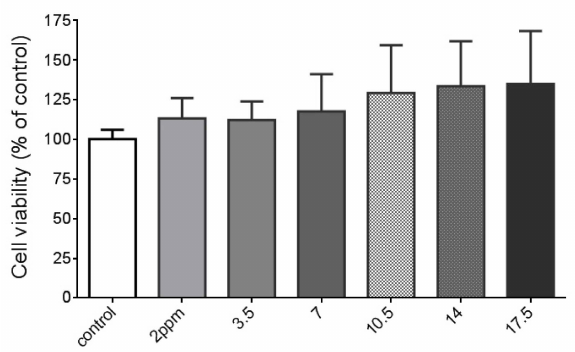
Figure 1. Effects of di(2-ethylhexyl) phthalate (DEHP) on cell viability in vascular smooth muscle cells (VSMC). VSMC ( n ě 8) were treated with DEHP (concentrations between 2 and 17.5 ppm) for 24 h prior to cell viability being